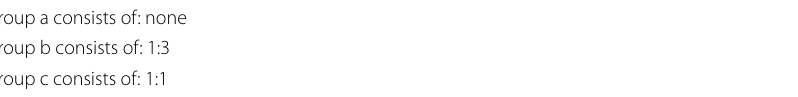
Table 14 HSD test groupings after ANOVA of AUPRC for the RUS factor